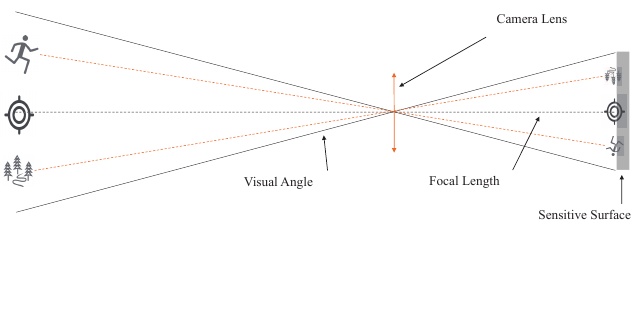
Figure 2. Pinhole camera model.